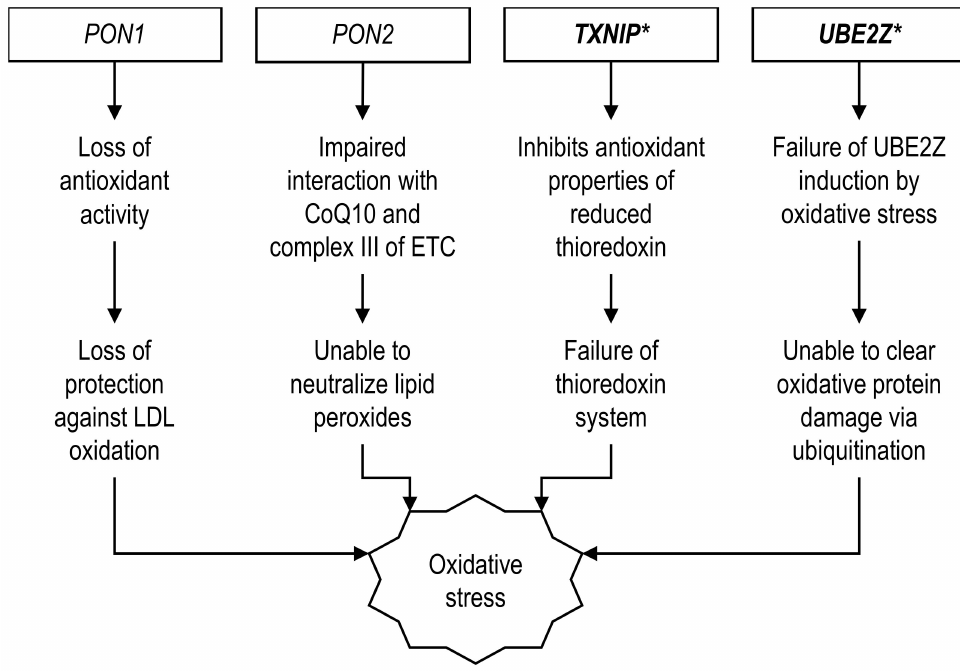
Figure 3. Proposed mechanisms of genes related to antioxidation mechanisms associated with CHD in the T2D Asian population. * Significant association with CHD exclusive in T2D Asians but not T2D Caucasians. Abbreviations: CoQ10 (coenzymeQ10 or ubiquinone), ETC (electron transport